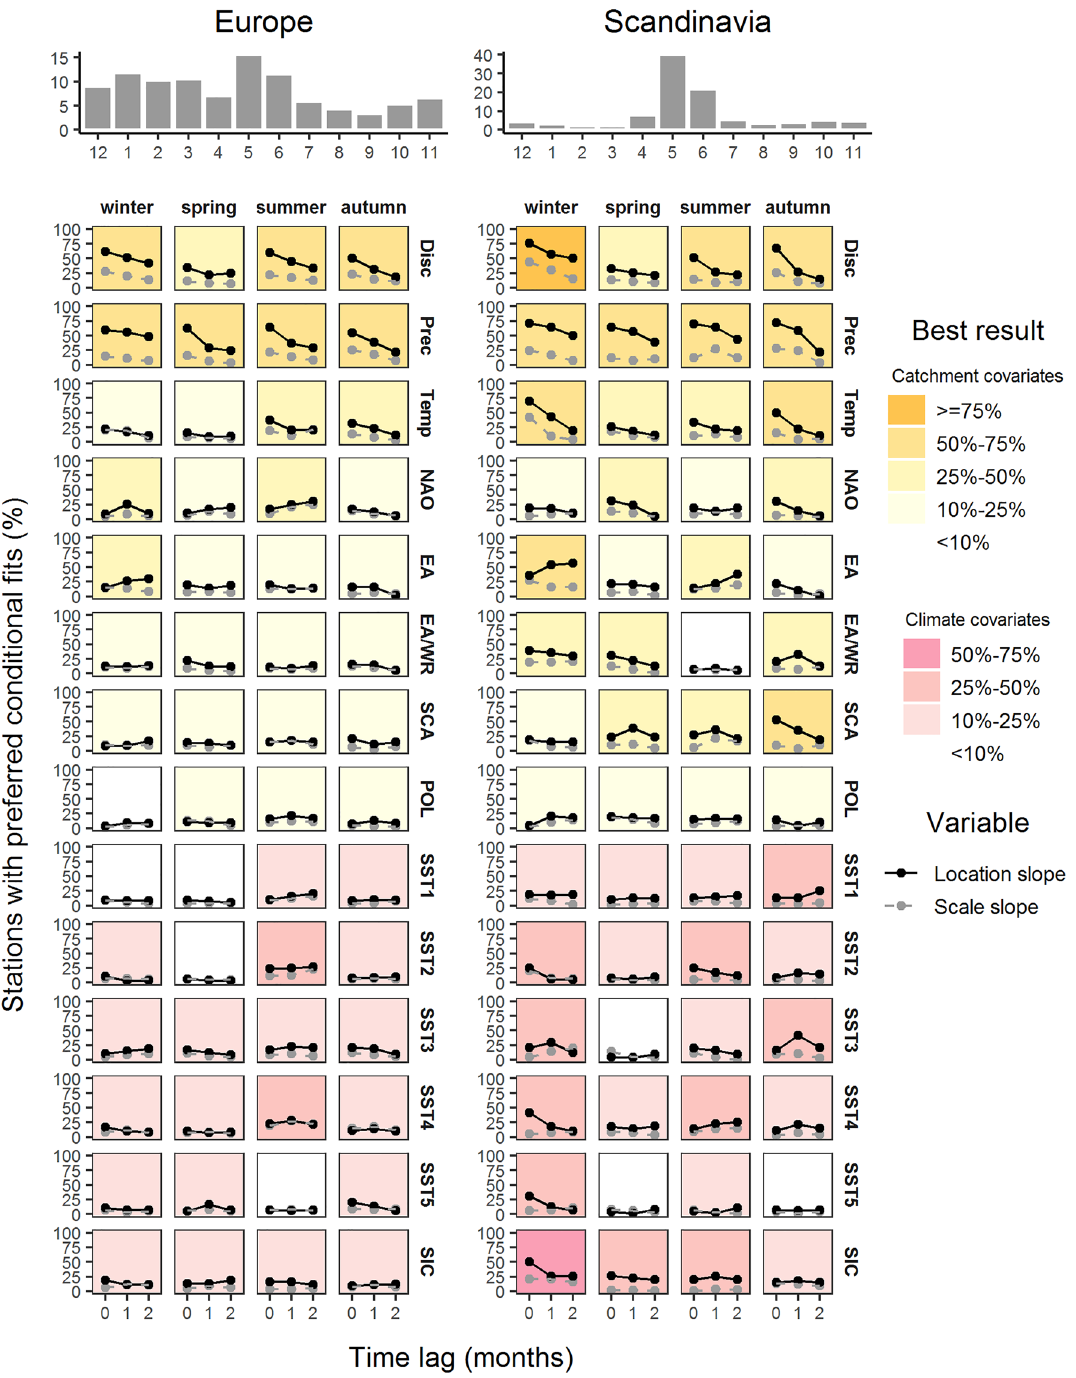
Figure 1. Summary of preferred conditional models for all 14 covariates, all seasons and the three lead times. Results are shown for the whole of Europe (left) and Scandinavia (right). In the main panel, the solid (dashed) lines show the percentage of stations for which the respective covariate has an effect on the location (scale) slope. The legend colour refers to the best result (highest station percentage) with an effect on the location slope among the three lead times. Catchment and climate covariates are differentiated by color palette, orange and pink, respectively. On top of the main panel, flood seasonality for the two regions is given as histogram of the percent monthly relative frequency of annual maximum streamflow. The figure was created using the R package ggplot2, version